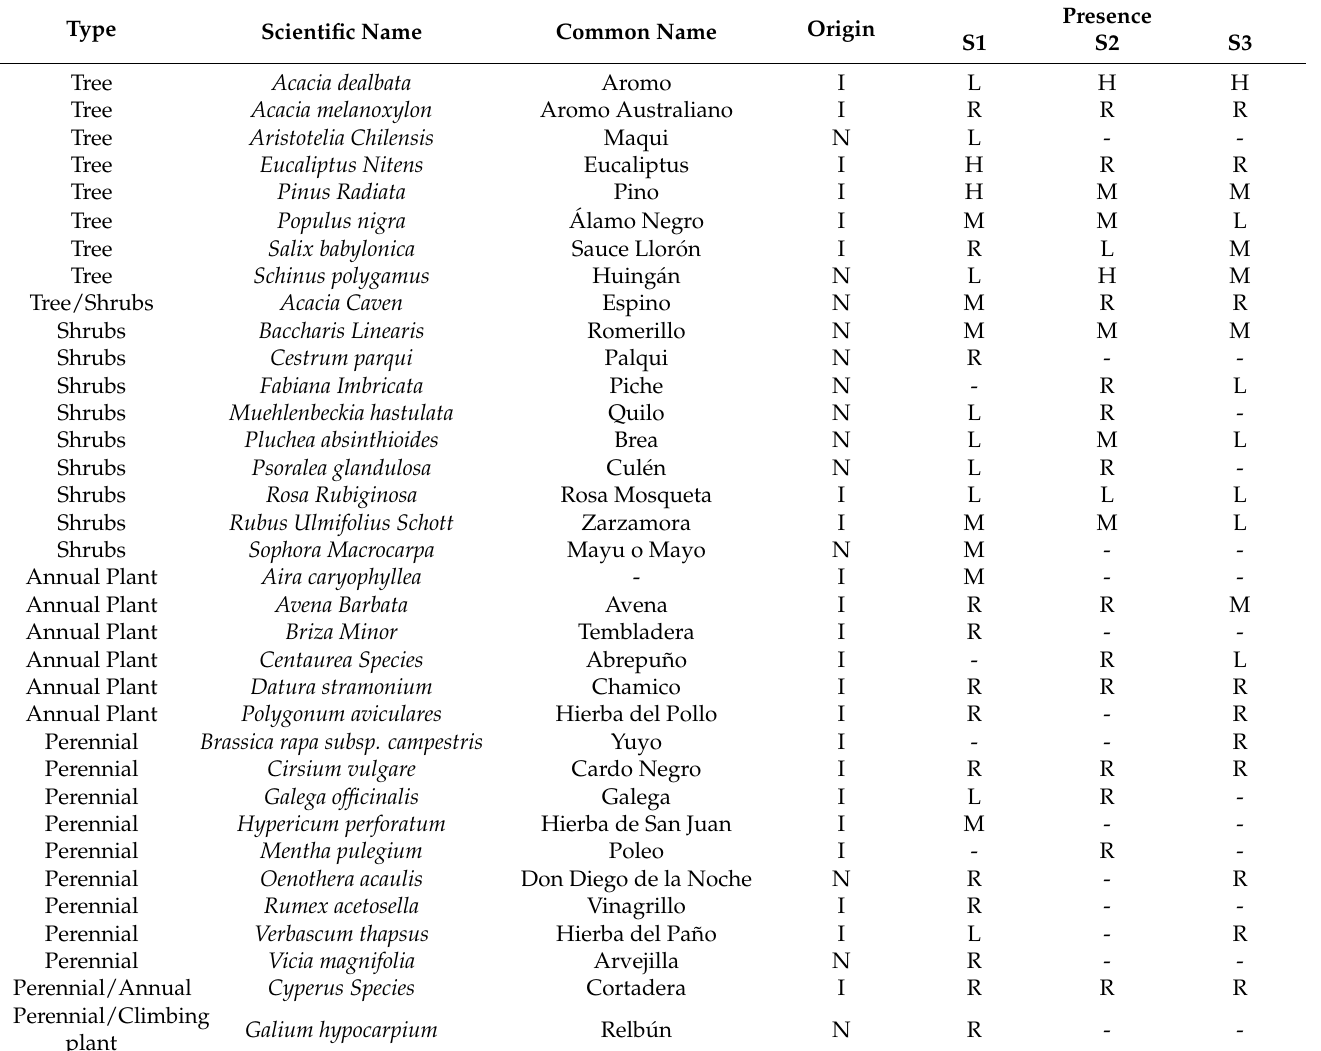
Table A2. Identification of tree, shrub, and herbaceous species in the study